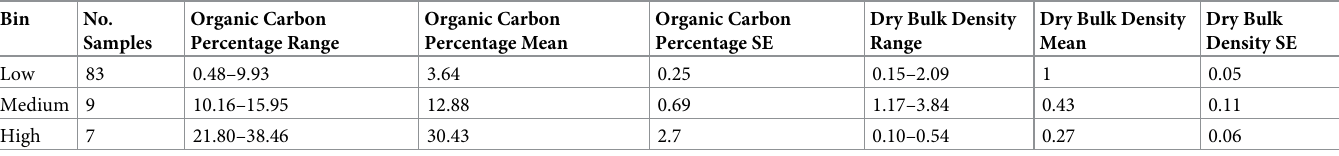
Table 4. Summary of soil organic percentage values derived from sample data.